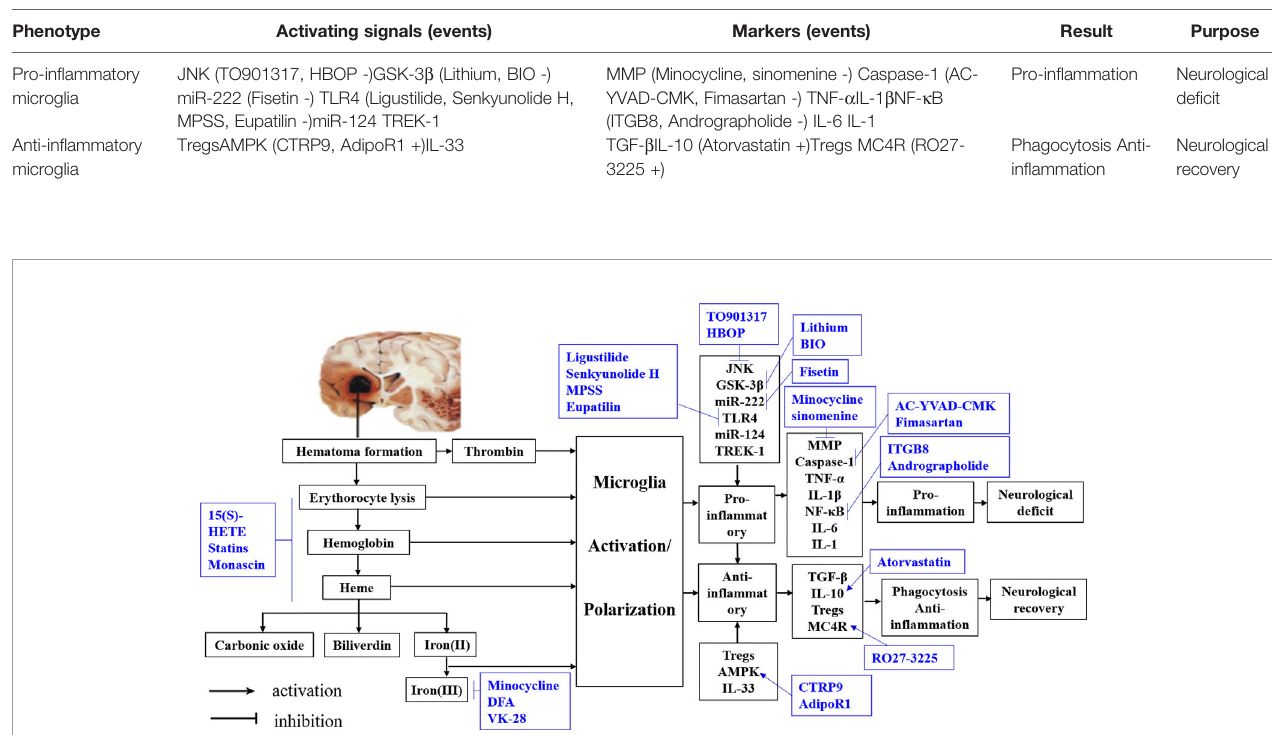
TABLE 1 | Potential interventions for microglia polarization after intracerebral hemorrhage.